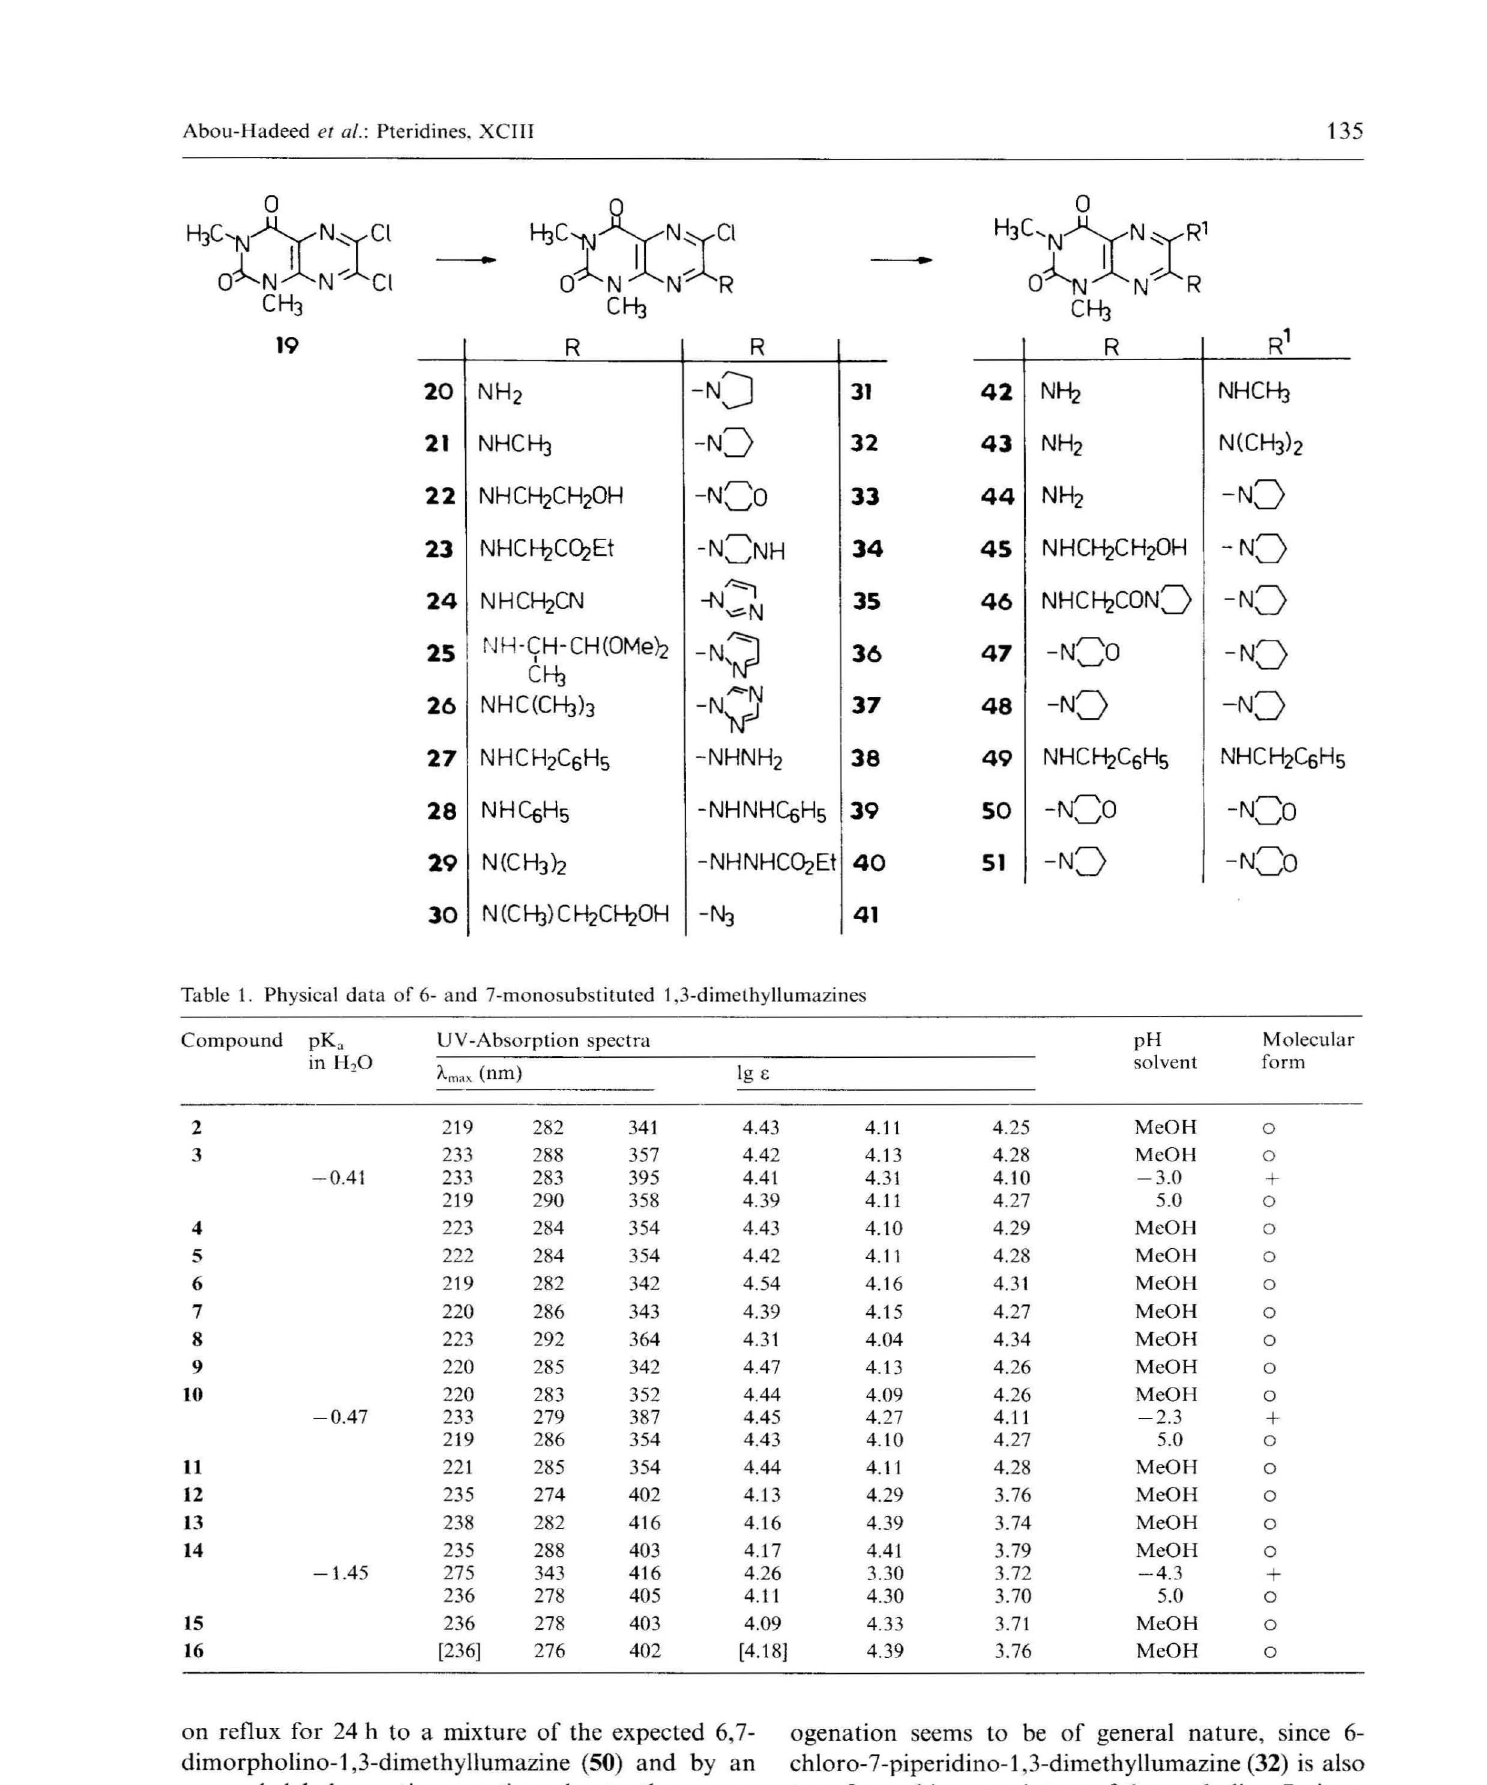
Table 1. Physical data of 6- and 7-monosubstituted 1,3-dimelhyllumazines Compound